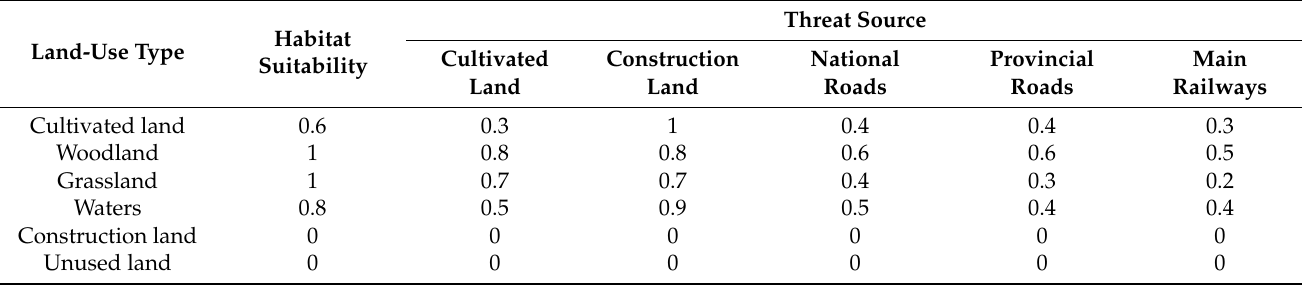
Table 4. Habitat suitability and its relative sensitivity to different threat sources.